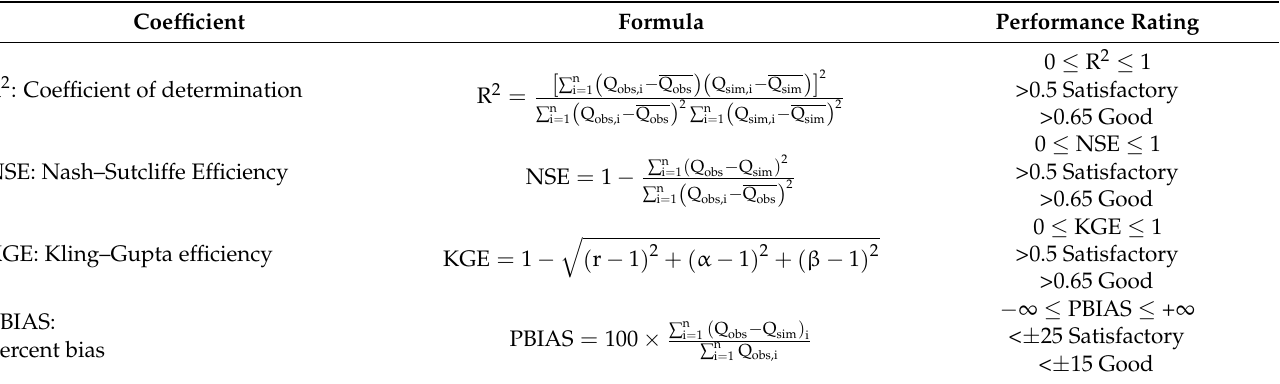
Table 2. List of employed statistical